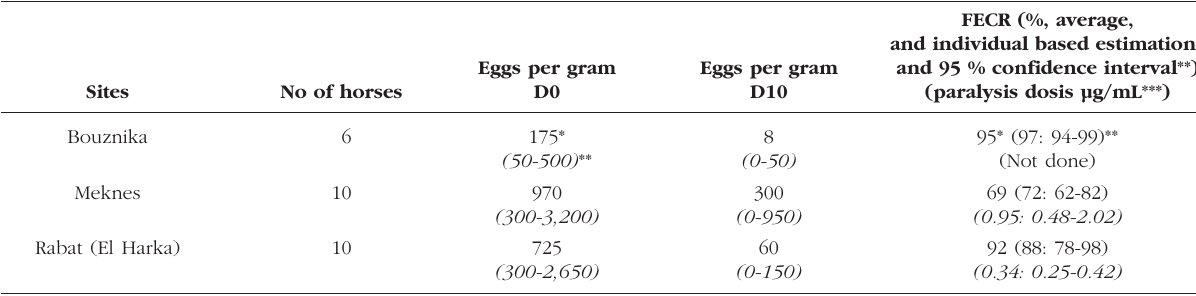
Table III. – Faecal egg count reduction test (FECR 10 days after treatment) with pyrantel pamoate in horses from three sites (6.6 mg/kg body weight).